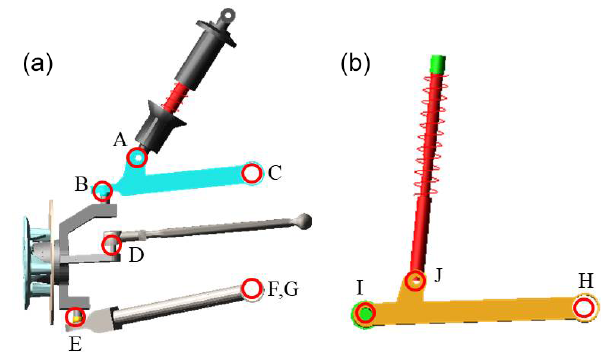
Figure 10. Force analysis at hardpoints in: (a) front suspension and (b) rear